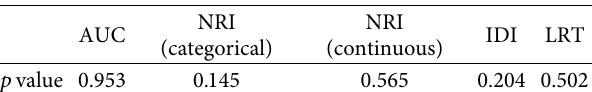
Table 3: Comparison between models 1 and